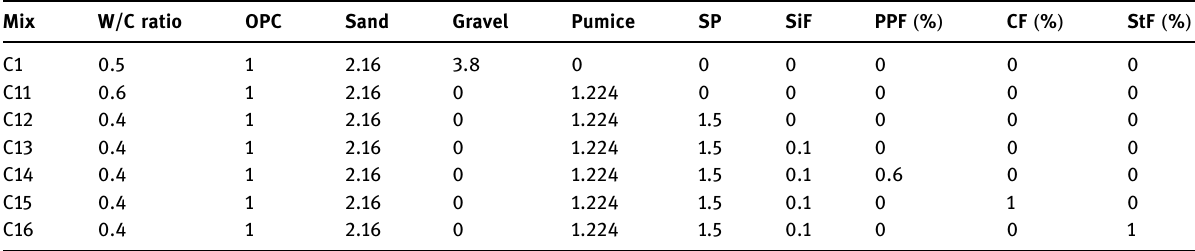
Table 7: Compositions of mixes with additives